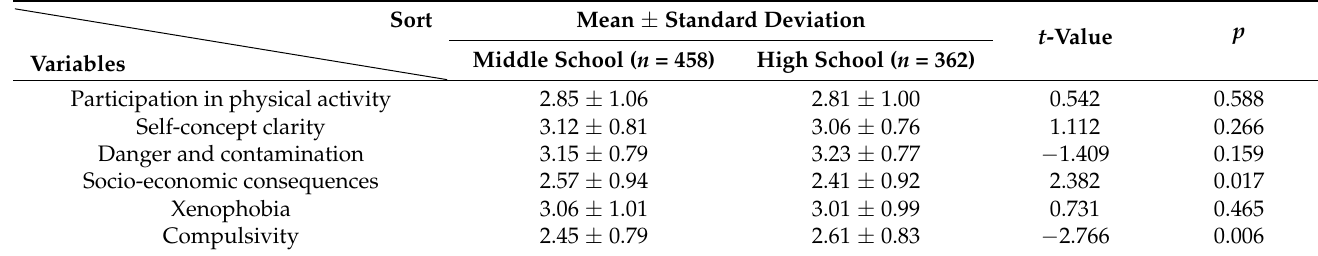
Table 8. Differences in each variable according to school level.